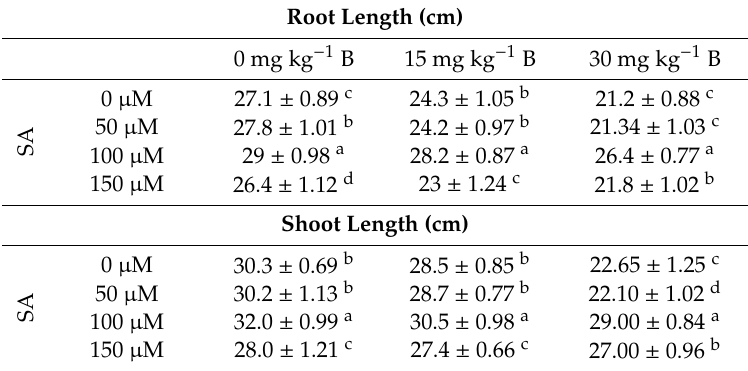
LSD 5% = 0.44. Values in the same column with di ff erent letters in superscript di ff er significantly.